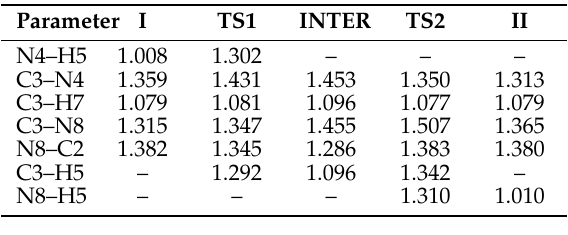
Table 3. Some selected optimized bond lengths of H-bonded imidazole-4-acetic acid (I) that tautomerized forming imidazole-5-acetic acid (II) through two transition states (TS1 and TS2) and an